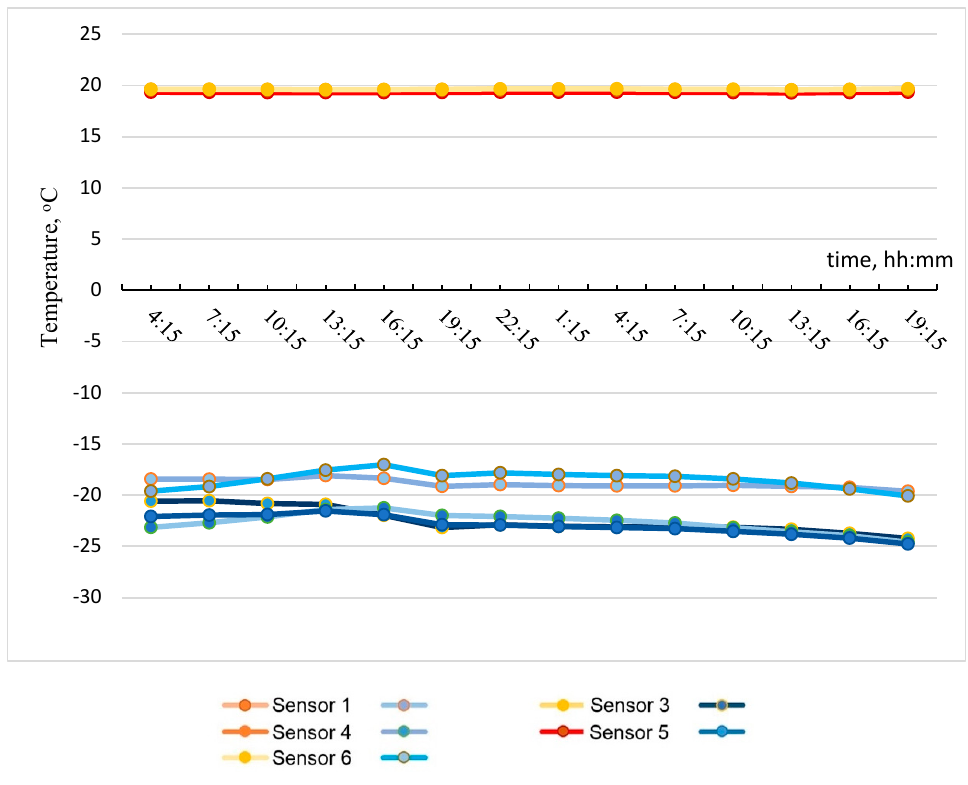
Figure 5. Temperature on specimen No. 1 surface with time.